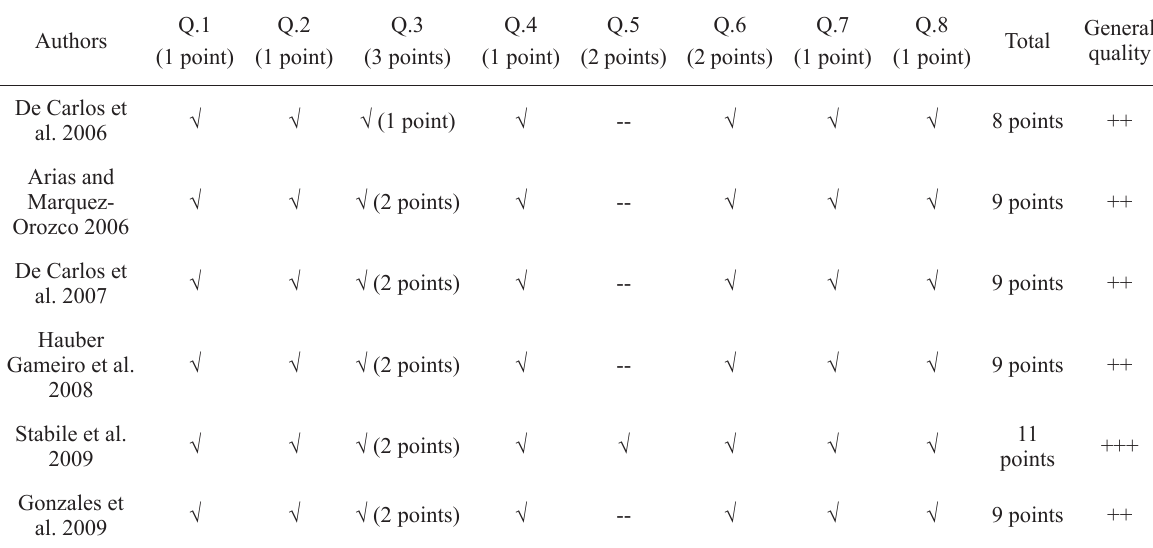
Assessment of risk of bias and individual quality of eligible articles. Scores and criteria used as proposed